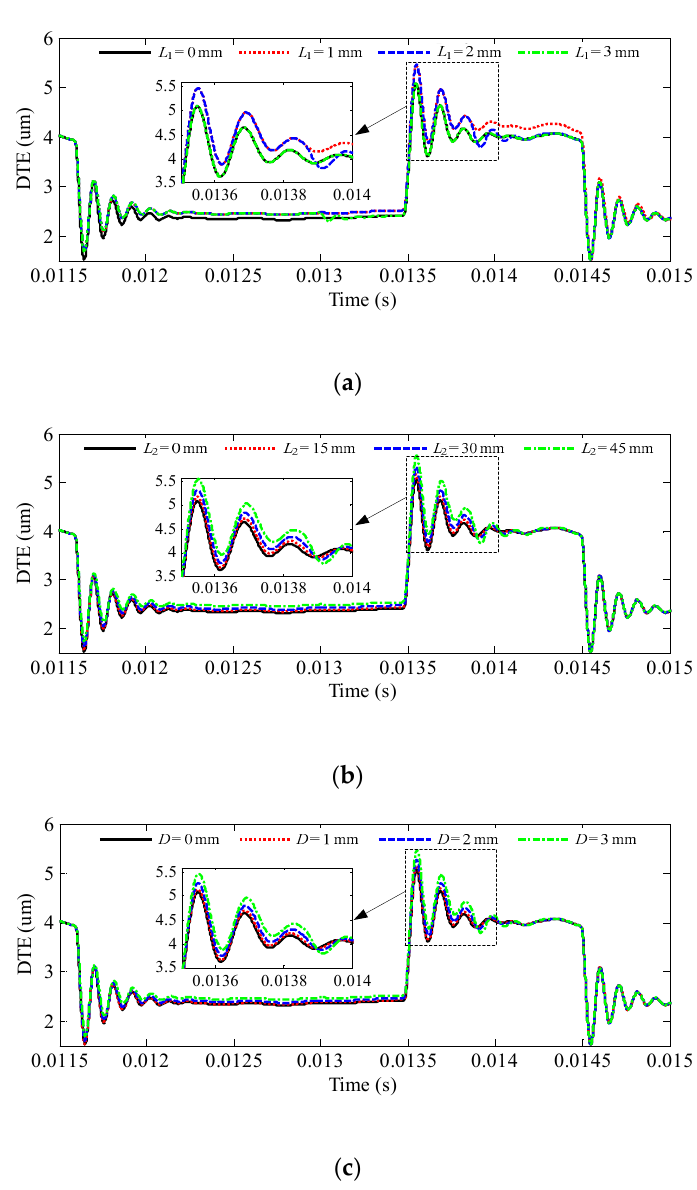
Figure 8. Effects of crack parameters on the DTE: ( a ) length, ( b ) width, ( c ) depth.